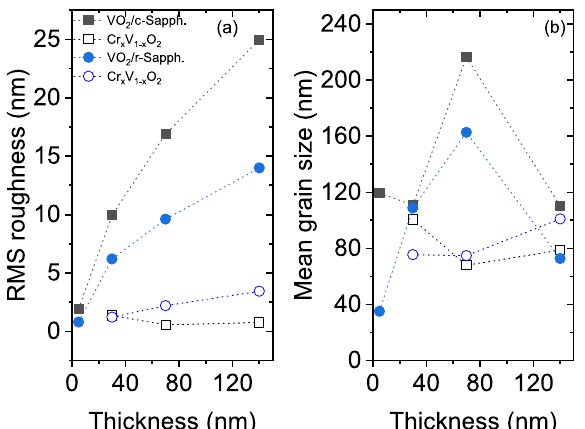
Figure 2. RMS roughness ( a ) and mean grain size ( b ) for various film thicknesses of undoped and Cr-doped VO 2 on c- and r-plane sapphire